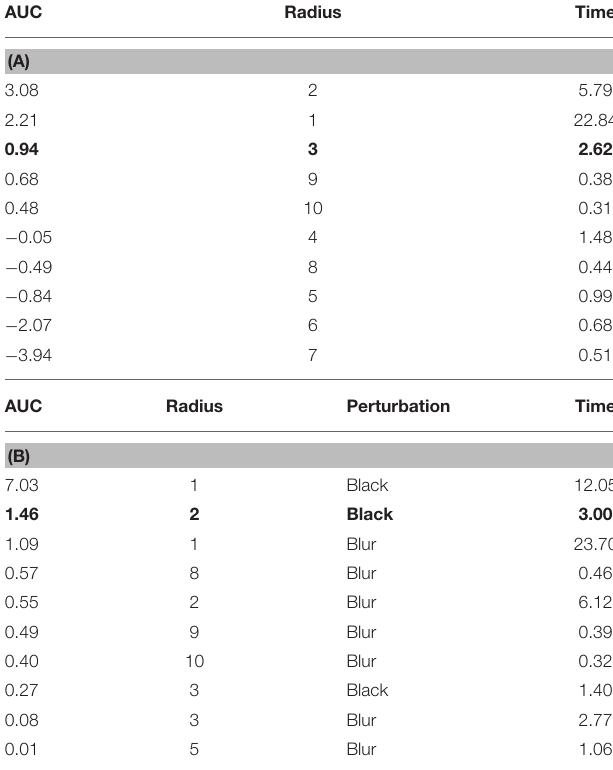
TABLE 3 | Best parameters for Noise Sensitivity (A) and SARFA (B)